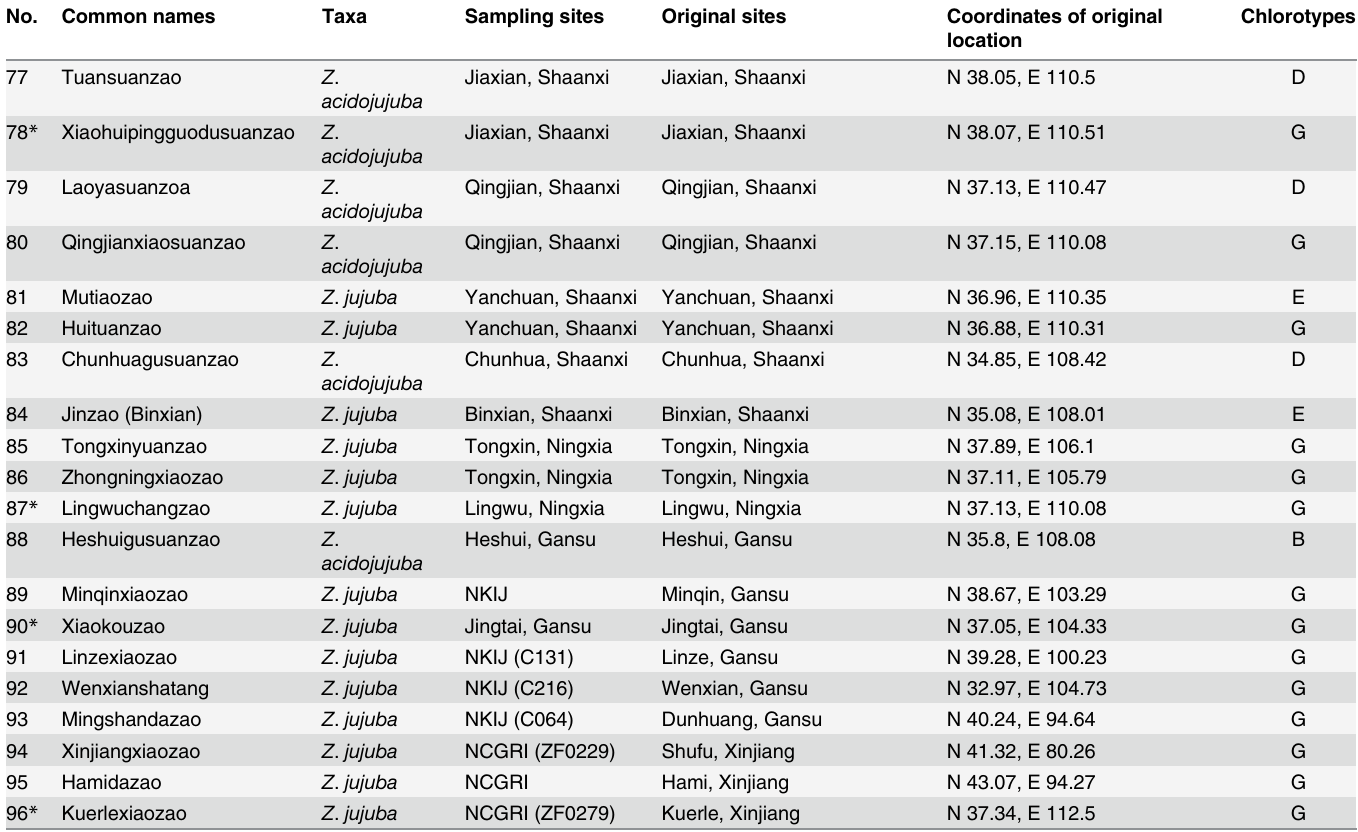
gels under UV light. Fifteen SSR loci amplified efficiently and showed one solid band under UV light, and these products were further electrophoresed on 6.0% (w/v) denaturing